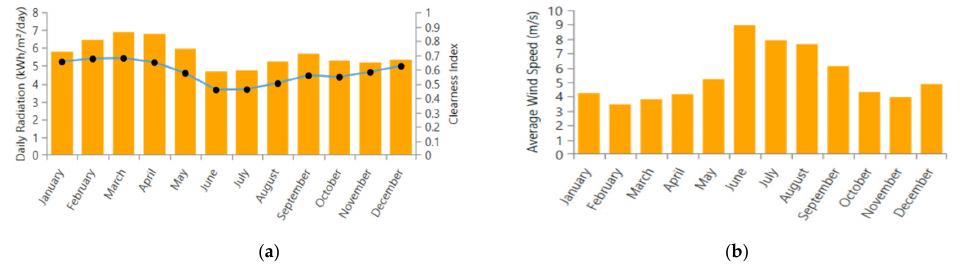
Figure 3. ( a ) Average solar radiation; ( b ) average speed of wind.